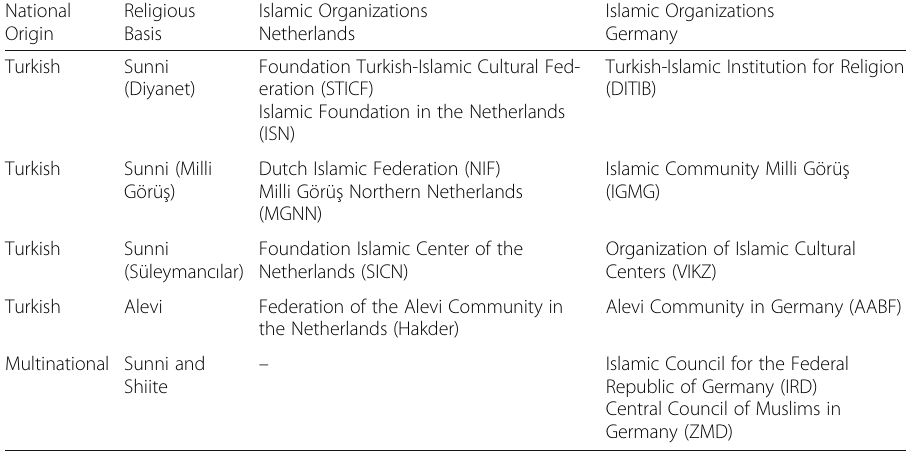
Table 2 Selected Islamic Organizations in Germany and the Netherlands National